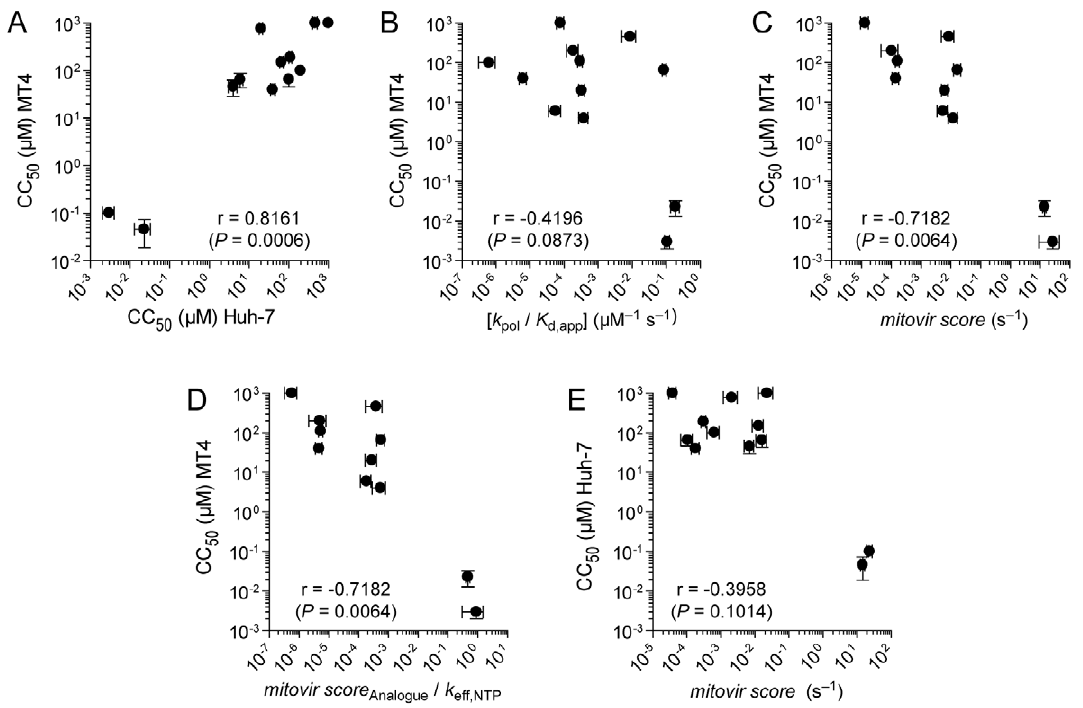
Figure 4. Predicting adverse effects of antiviral ribonucleosides during preclinical development: The mitovir score. Correlations between ( A ) cytotoxicity in Huh-7 cells and MT4 cells ( Table 1, CC 50 ), ( B ) cytotoxicity in MT4 cells ( Table 1, CC 50 ) and the efficiency of nucleotide incorporation ( Table 2, k pol / K d,app ), ( C ) cytotoxicity in MT4 cells ( Table 1, CC 50 ) and mitovir score for MT4 cells ( Table 2 ), ( D ) cytotoxicity in MT4 cells ( Table 1, CC 50 ) and the mitovir score for each analogue corrected to account for the presence of the nucleotide with which the analogue competes, ATP or CTP, and ( E ) cytotoxicity in Huh-7 cells ( Table 1, CC 50 ) and mitovir score for Huh-7 cells ( Table 2 ). Error bars represent s.d. Nonparametric (Spearman) correlations with r values shown. In parentheses are one-tailed P-values calculated from Spearman coefficients to provide a measure of statistical significance of correlation.